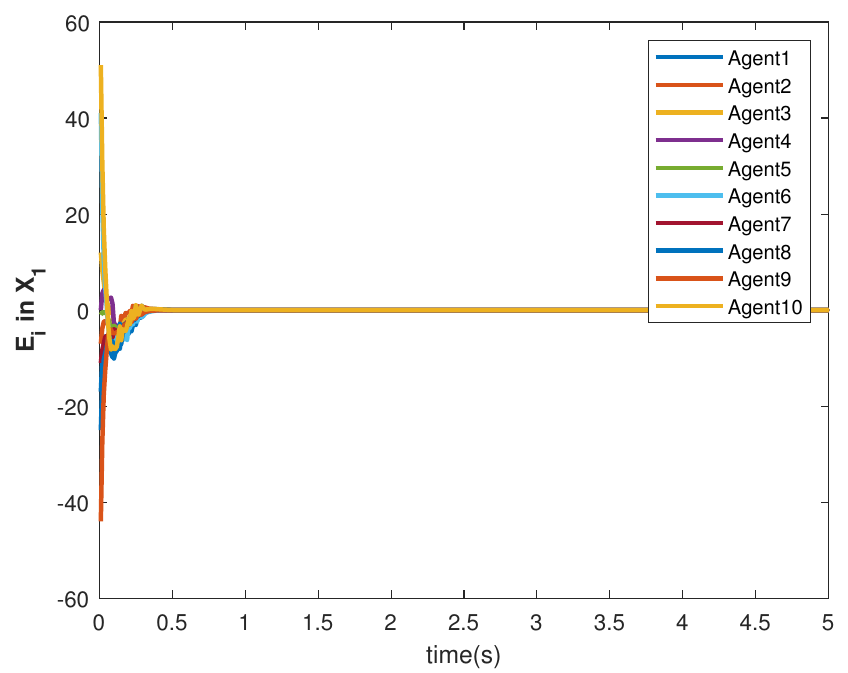
Figure 5. Consensus error E i in state X 1 of